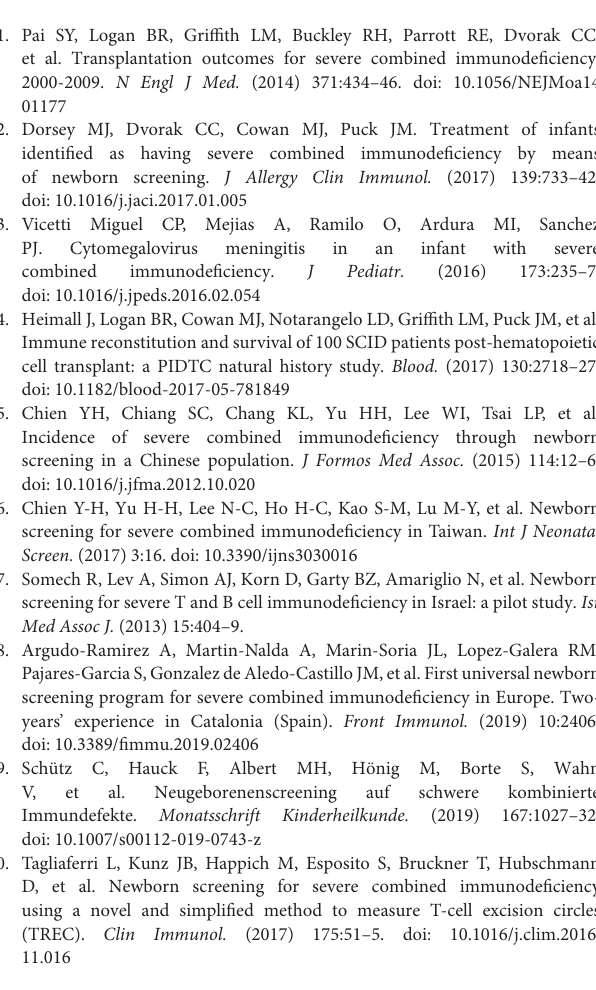
Supplemental Table S1 | New SCIDs and severe T cell deficiencies detected in the pilot project. Supplemental Table S2 | The individuals with the lowest TREC values in the pilot project. Supplemental Table S3 | Individuals with PIDs born outside pilot test region. Supplemental Table S4 | Retrospective study: TRECs and NGS on DNA from the original NBS DBS in individuals with known SCID or severe T cell deficiency. Supplemental Table S5 | New SCIDs and severe PIDs identified during the national newborn screening. Supplemental Table S6 | The individuals with the lowest TREC values on the national screening 2018-2019. Supplemental Table S7 | Newborn screening gene panels, versions